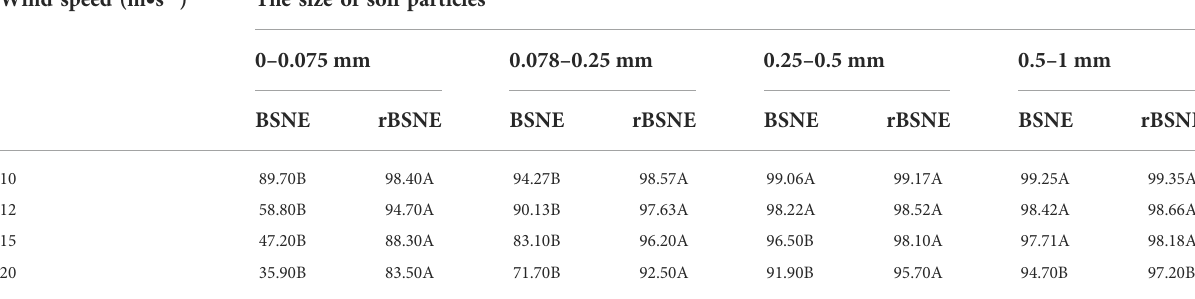
Different uppercase letters (A – B) indicate signi fi cant differences at p < 0.05 between the BSNE, and rBSNE, samplers.